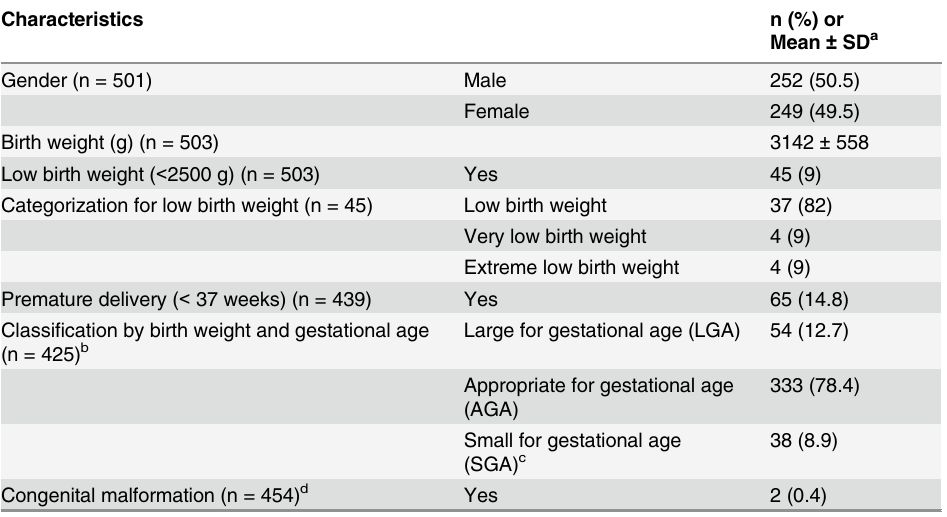
Table 2. Baseline characteristics of newborns of study pregnant women.